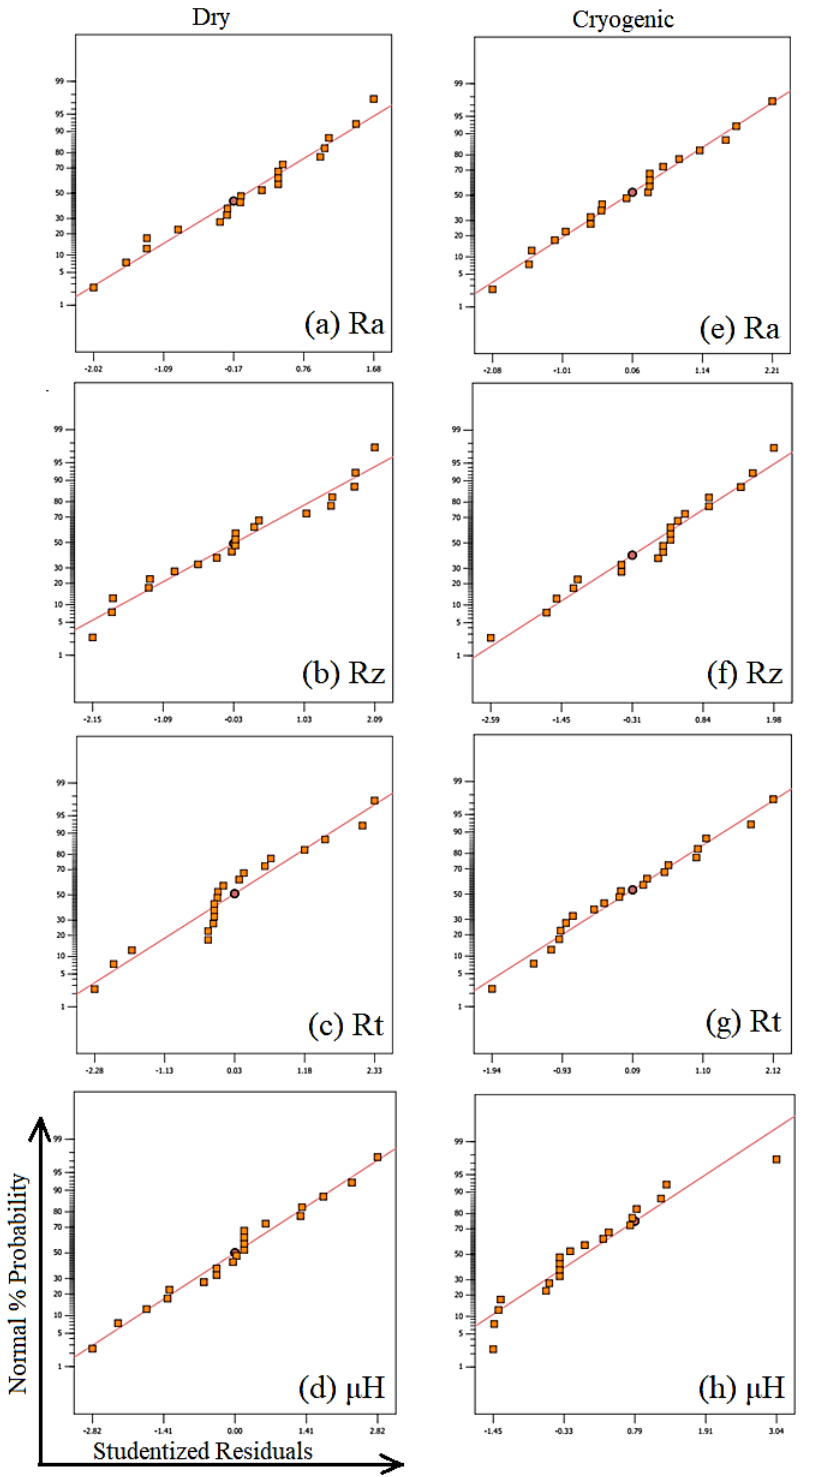
Figure 3. Normal plots of residuals of all the developed models for turning AZ31 Mg alloy. The models were also checked for any constant error occurred during the experimen- tations. This can be visualized with residual verses predicted plots. The points in these plots should be randomly distributed and should not exceed the limits ( − 3 to 3). The residual verses predicted plots of the models developed in the current study were found